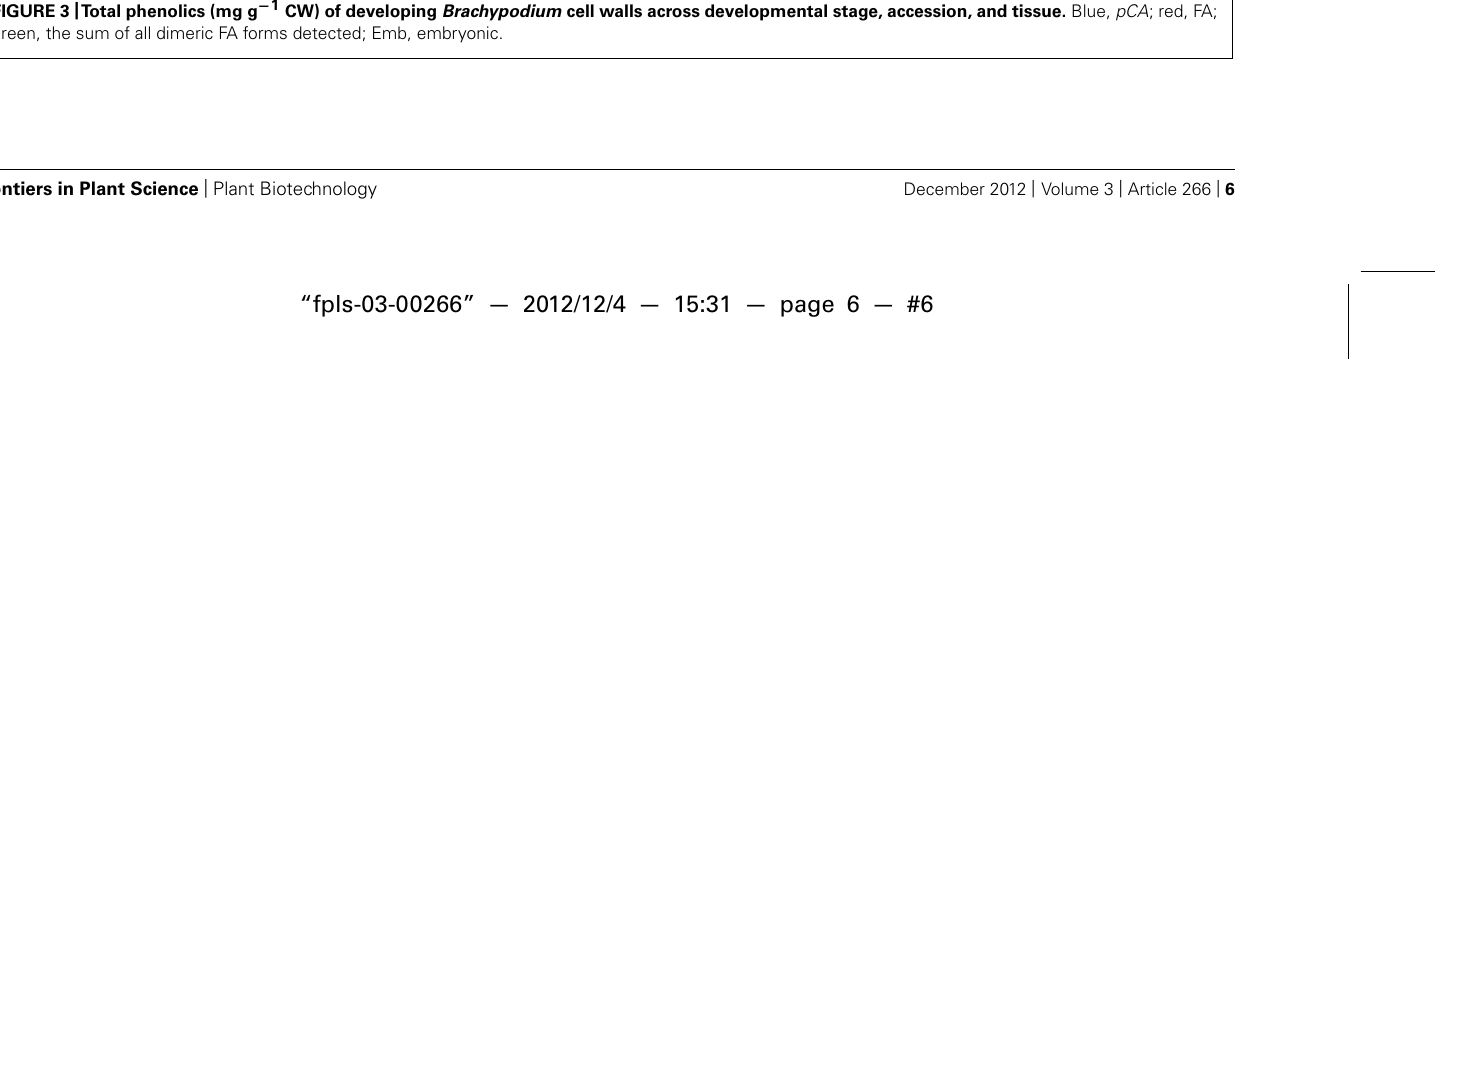
FIGURE 3 |Total phenolics (mg g − 1 CW) of developing Brachypodium cell walls across developmental stage, accession, and tissue. Blue, pCA ; red, FA; green, the sum of all dimeric FA forms detected; Emb, embryonic.